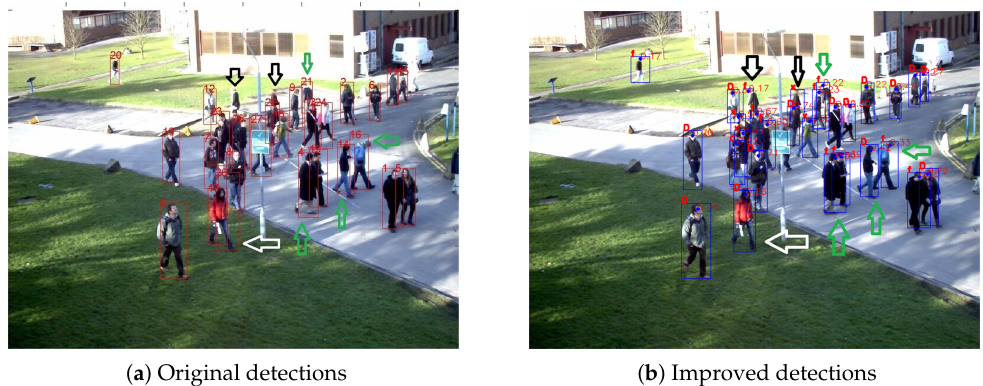
Figure 2. Results of the optimization method based on human key points detection. ( a ) The original detections; ( b ) the optimized results. The white arrow indicates the processing of a false detection, the black arrow indicates the compensation of missed detection using the key points, and the green arrow indicates that key point information is used to optimize not only the coordinates of the bottom points, but also the overall detection bounding